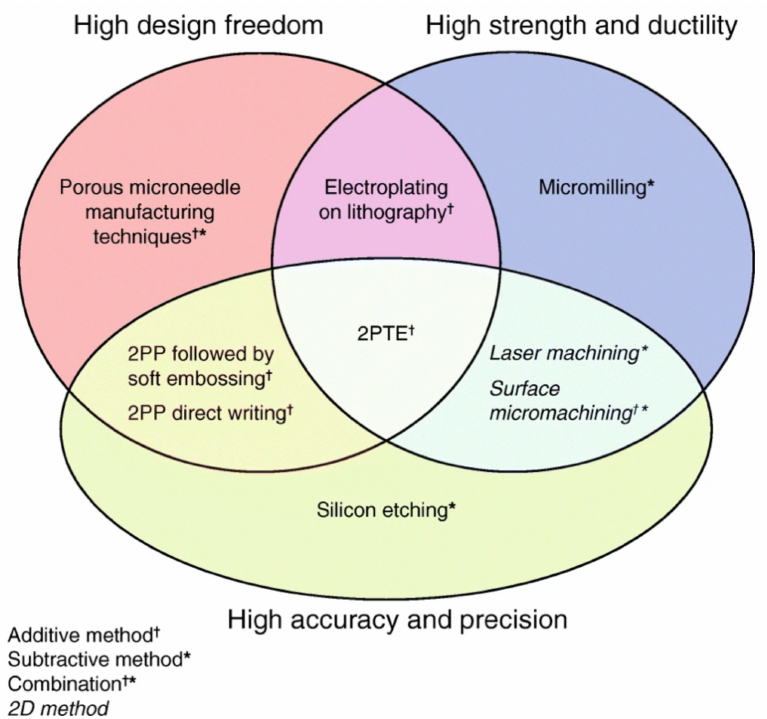
Figure 2. Attributes of different microneedle manufacturing techniques. † Additive method. * Sub- tractive method. † * Combination method. Italics: 2D method. (Reprinted with permission from Ref. [38], 2020, Jeffrey W. Kysar, PhD and Anil K. Lalwani,